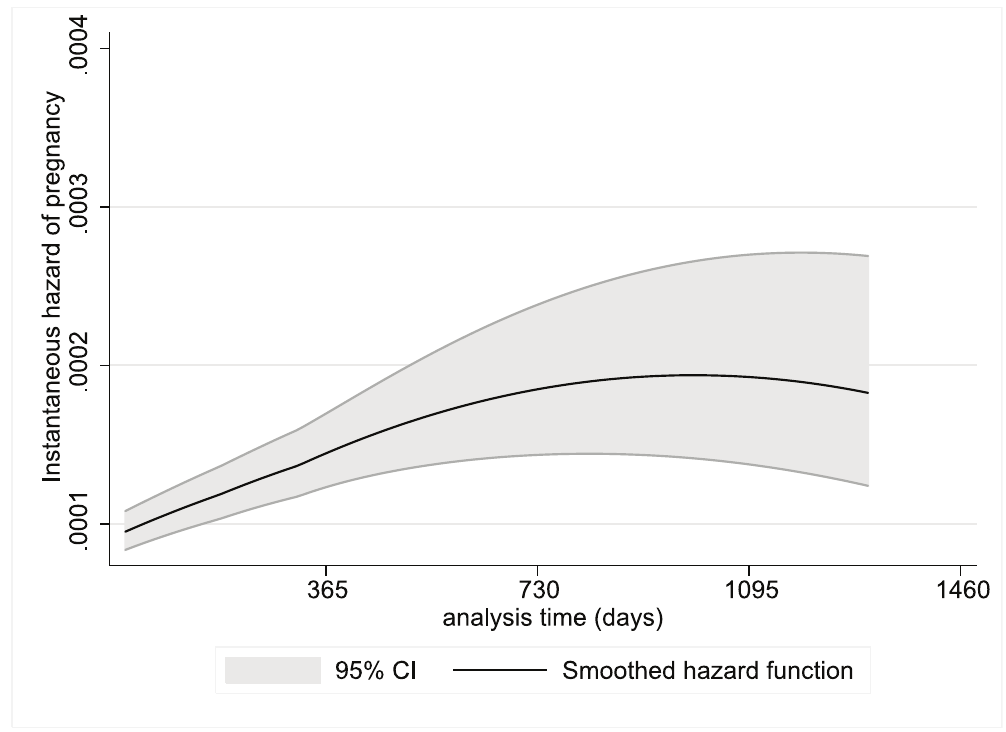
Figure 1. Instantaneous hazard of pregnancy during the pre-ART period by duration of follow-up, with 95% CIs.